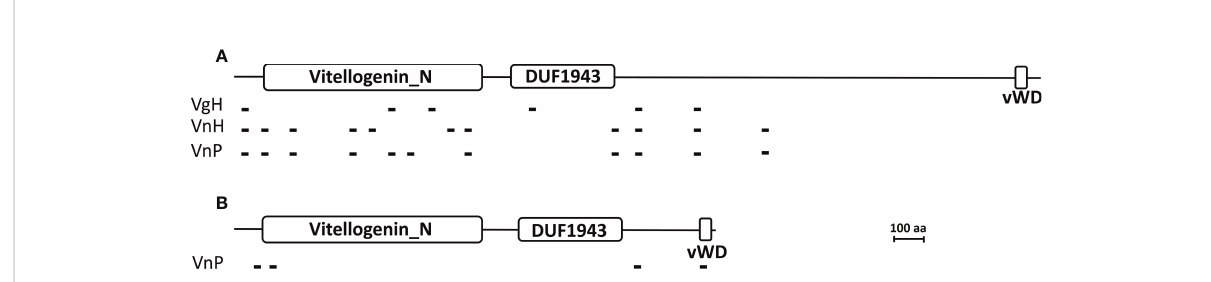
FIGURE 11 Mapping of the tryptic peptide fragments of vitellogenin and vitellin onto brachyuran and parasite vitellogenin. (A) Matching tryptic peptide fragments derived from the hemolymph Vg of parasitized male hosts (VgH), the ovarian Vn of non-parasitized female hosts (VnH), and the externa Vn of the parasite P. planus (VnP) are mapped onto the Chinese mitten crab Eriocheir sinensis Vg. (B) Matching tryptic peptide fragments derived from the externa Vn (VnP) are mapped onto the parasite Vg. Large white rectangles indicate the signature domains of the vitellogenin family, the N-terminal Vitellogenin-N domain (Vitellogenin_N), the domain of unknown function 1943 (DUF1943), and the C- terminal Von Willebrand D domain (vWD) (see Zhang et al., 2011). Small black blocks indicate the tryptic fragments, the sequence of which are given in Supplementary Table 2. Accession number for the Chinese mitten crab Eriocheir sinensis Vg and the parasite P. planus Vg is MH621336 and OP556485, respectively. Scale bar = 100 amino acids in length for both